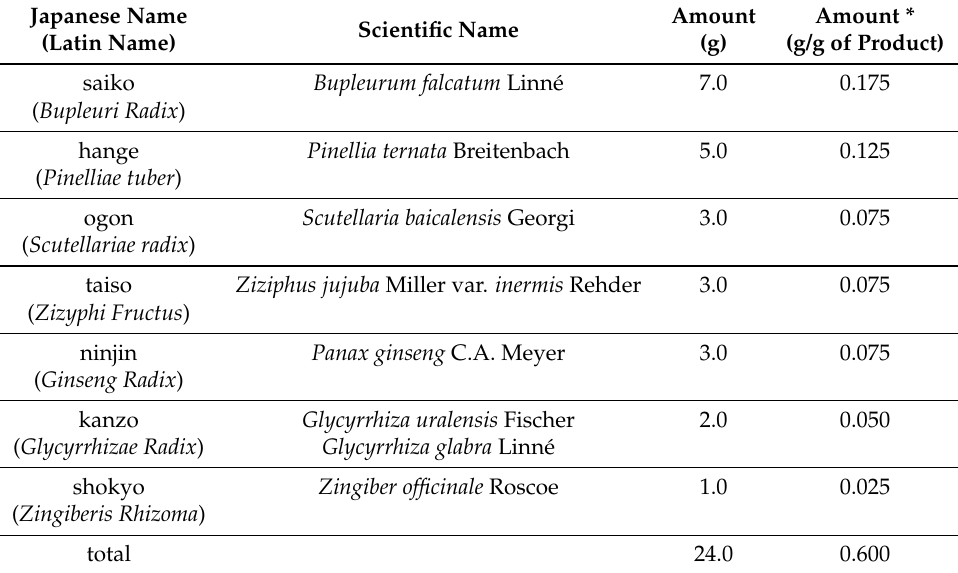
Table 3. The ingredients in the shosaikoto (TJ-9)